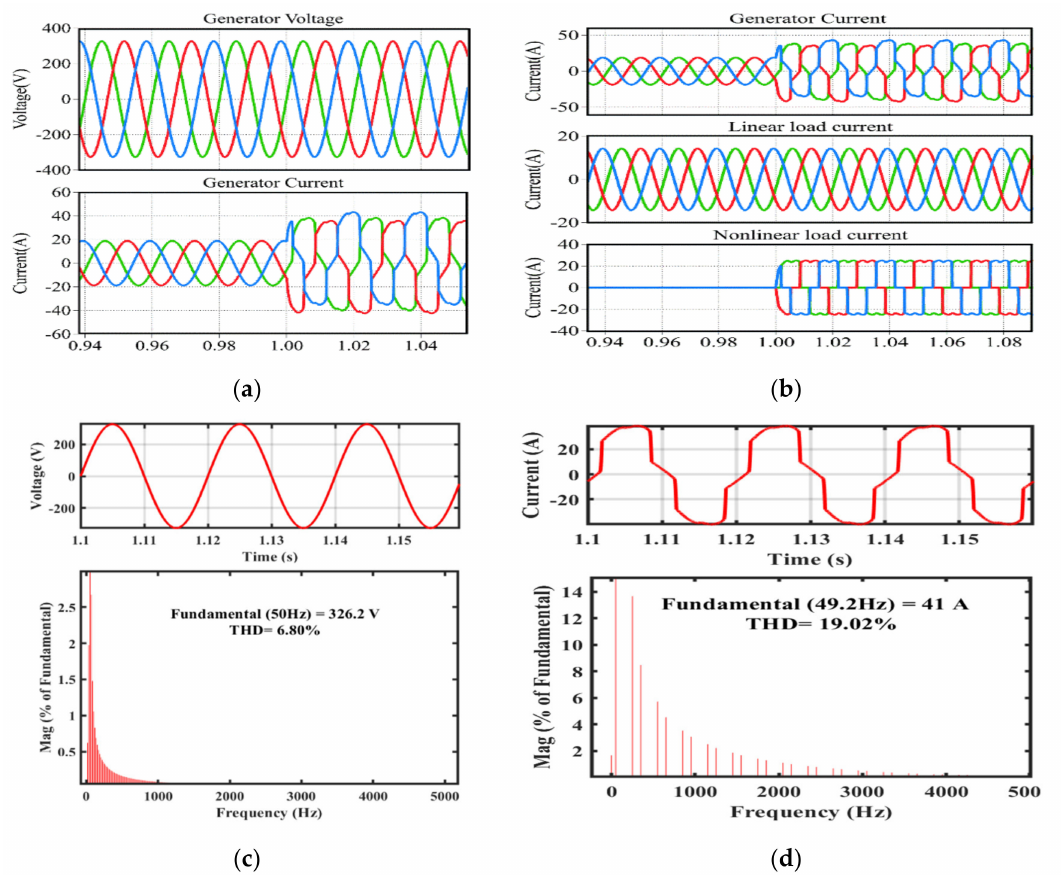
Figure 8. Overall results without control at point of common coupling (PCC): ( a ) generator voltage and current signals without control, ( b ) overall system current signals without control, ( c ) harmonics spectrum of generator voltage without control, ( d ) harmonics spectrum of generator current without control.